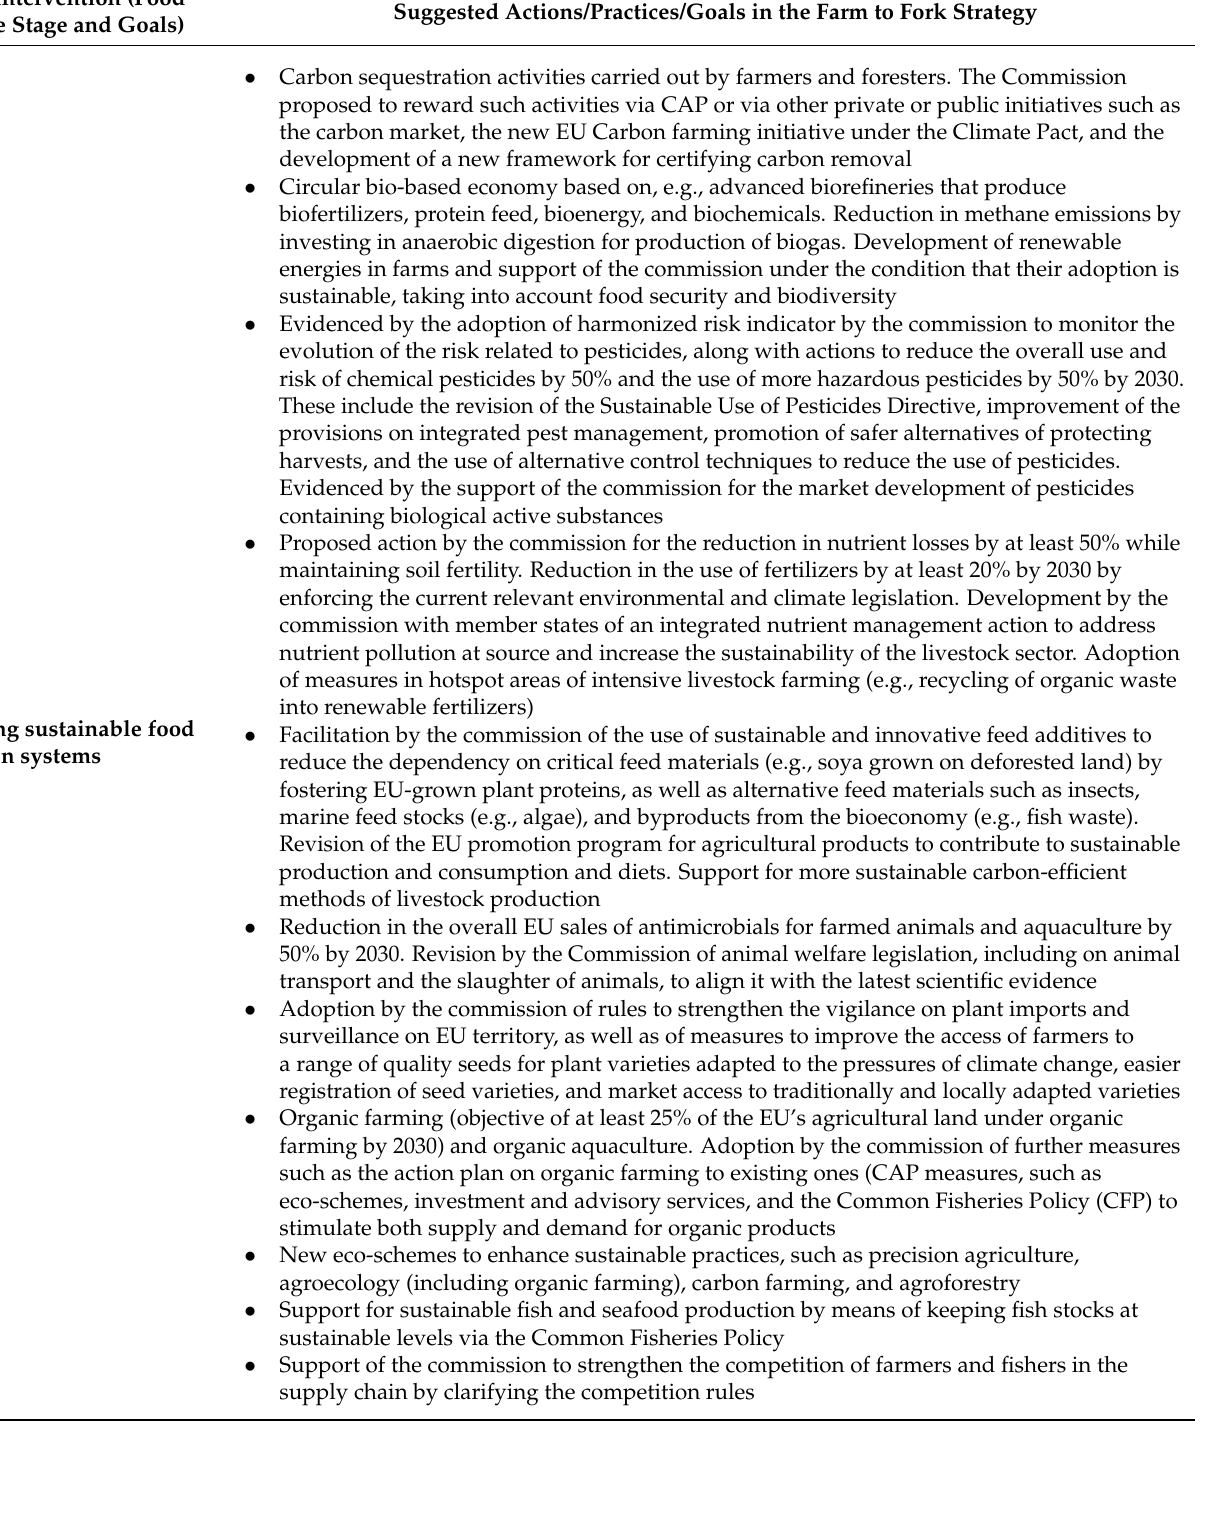
Table A1. Summary of the framework proposed in the farm to fork strategy of the European Commission